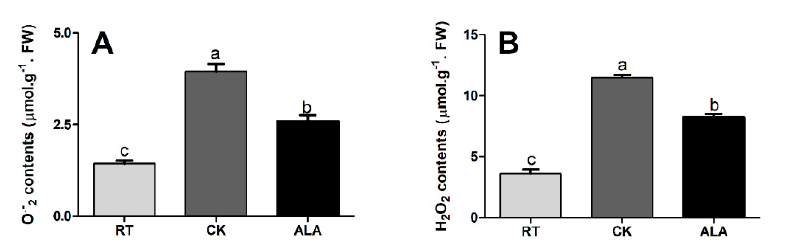
Figure 4. The effect of ALA on O 2 •− ; superoxide ( A ) and H 2 O 2 ; hydrogen peroxide ( B ) levels under low-temperature stress. RT = regular temperature; CK = control; ALA = 30 mg/L ALA. Different letters indicate a significant difference at p < 0.05.